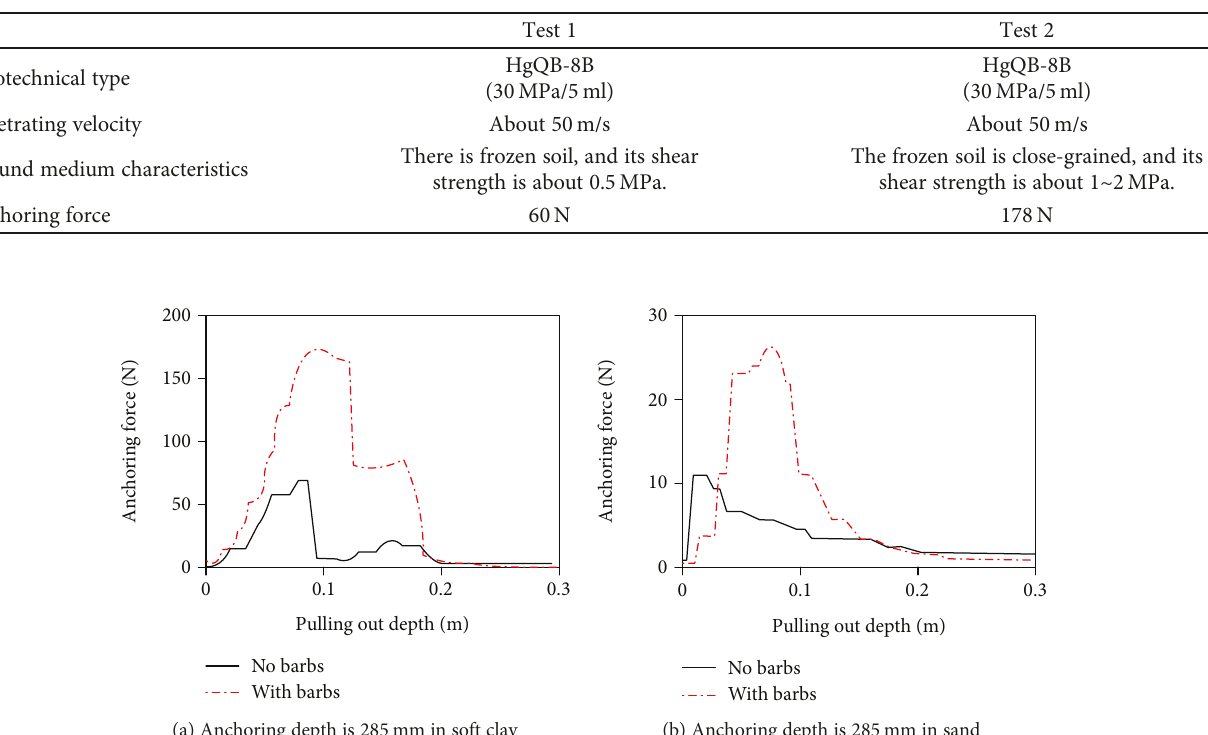
Figure 20: Test in ground soil geology. Table 4: Testing results of anchoring system in ground medium.